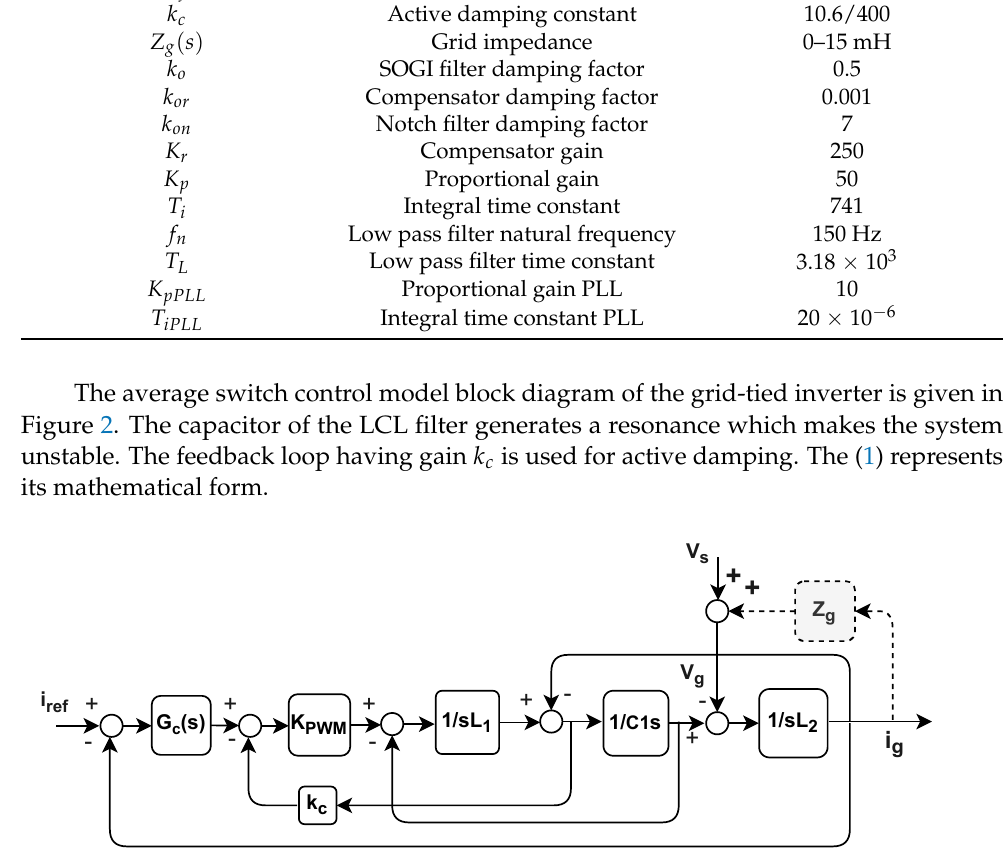
Figure 2. The average switch control model of grid tied